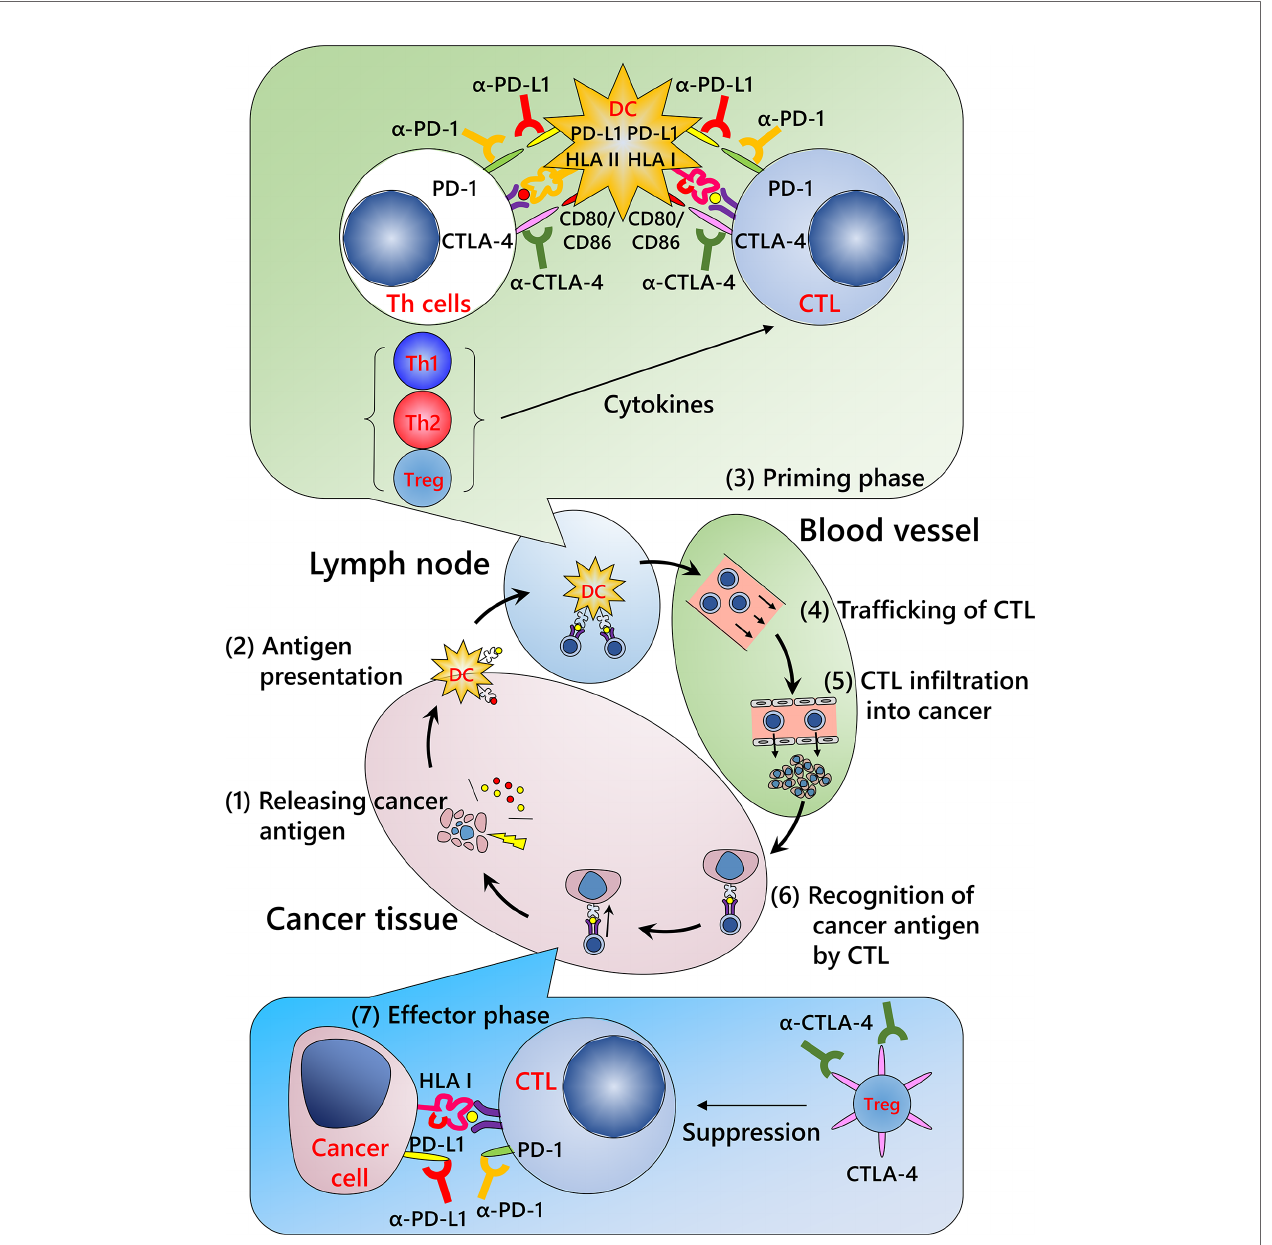
FIGURE 1 | Cancer immunity cycle and mechanism of immune checkpoint inhibitors. (Step 1) Release of cancer antigens from injured tumor cells; (Step 2) uptake of cancer antigens by dendritic cells and antigen presentation; (Step 3) priming phase (T cell activation); (Step 4) migration of cytotoxic T lymphocytes (CTLs) into the tumor; (Step 5) in fi ltration of CTLs into the tumor; (Step 6) recognition of cancer antigens presented by HLA class I molecules of the tumor cells; and (Step 7) effector phase (destruction of tumor cells). Repeated cycles of the cancer immunity system can eliminate a tumor. Modi fi ed from Chen et al. (50) CTLA-4, cytotoxic T- lymphocyte-associated protein 4; DC, dendritic cell; HLA I, human leukocyte antigen class I molecules; HLA II, human leukocyte antigen class II molecules; PD-1, programmed death-1; PD-L1, programmed death ligand 1; Th1, type 1 helper T cell; Th2, type 2 helper T cell; Treg, regulatory T